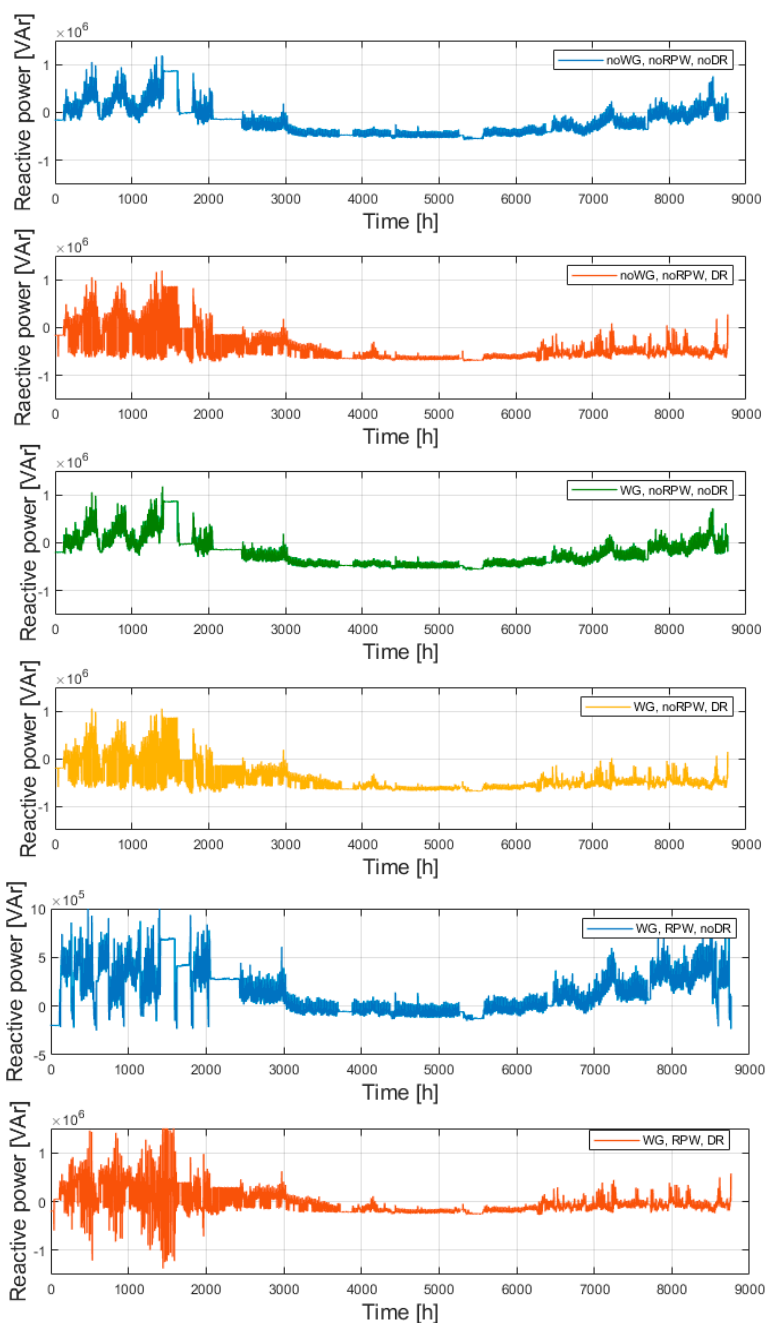
Figure 17. Reactive power control in the Sundom Smart Grid—reactive power flow at the HV/MV connection point in different case studies.